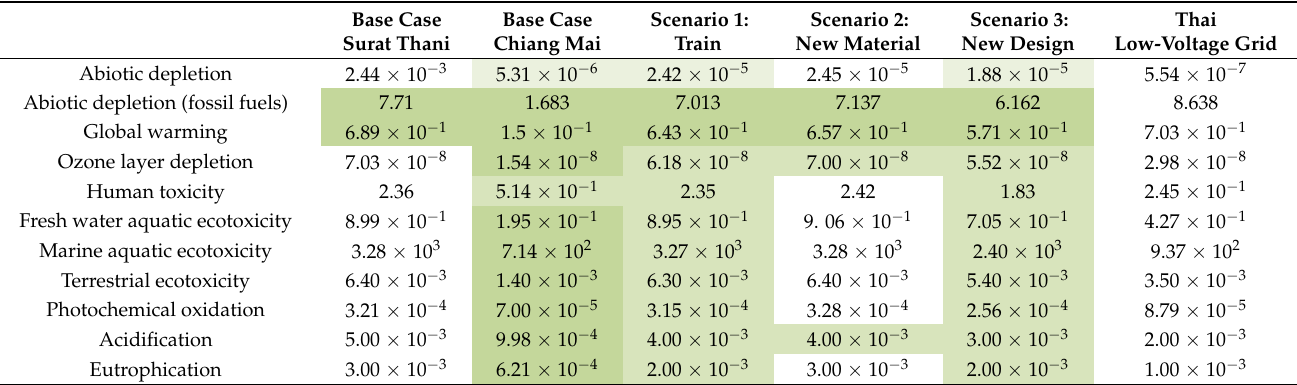
Table 11. Scenarios 1 to 3 vs. Surat Thani, Chiang Mai base cases and Thai low voltage mix impacts (per kWh). Light green indicates values less than the S. T. base case only; dark green indicates values less than both the S. T. base case and the Thai low voltage mix.